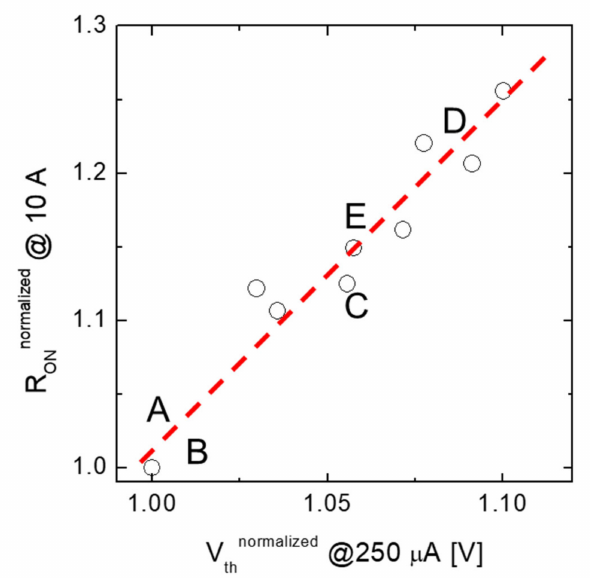
Figure 6. Empirical correlation between the on-resistance of a group of devices, R On at 10 A vs. Vth (measured at 250 µ A). Data are normalized to the values of sample